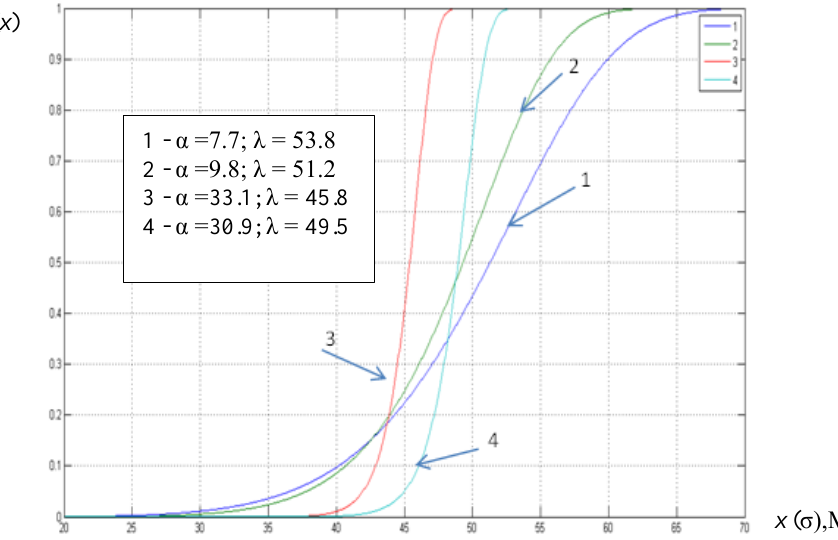
Fig.7 The Weibull distribution function F(x) for the form parameter α and the scale parameter λ determined from equations (3) - (6): (3) - curve 1; (4) - curve 2; (5) - curve 3, (6) - curve